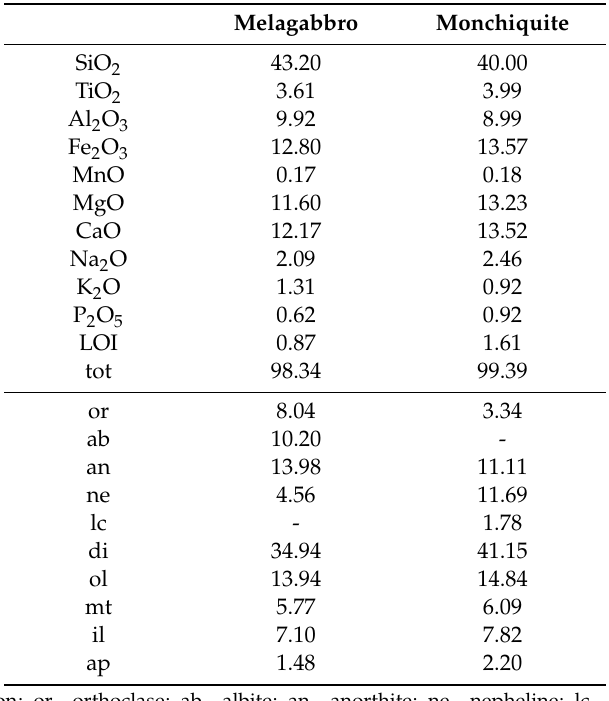
Table 1. Major oxide contents and CIPW normative composition of the melagabbro and monchiquite samples from San Giovanni in Pane. For norm calculation it was assumed a Fe 3 + / (Fe 3 + + Fe 2 + ) ratio of 0.30.